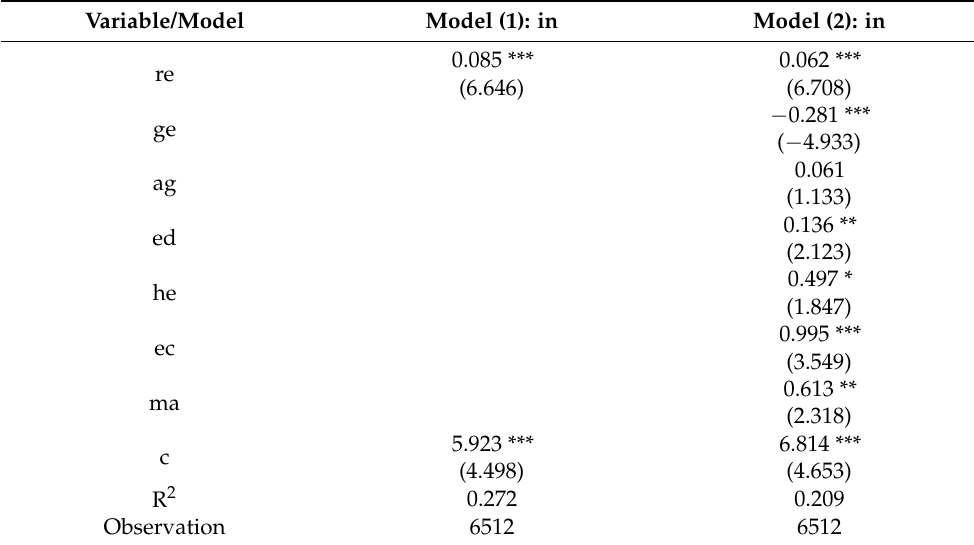
Table 3. Results of descriptive